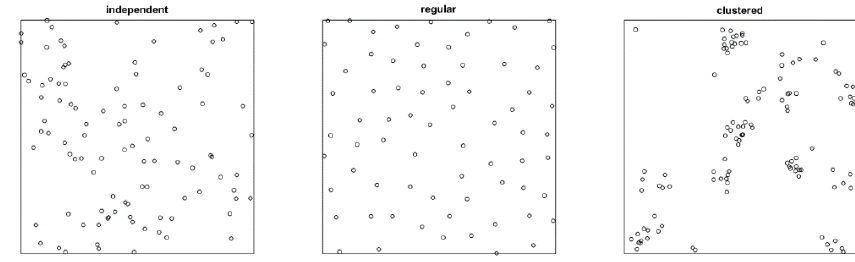
Figure 2. Types of spatial patterns.